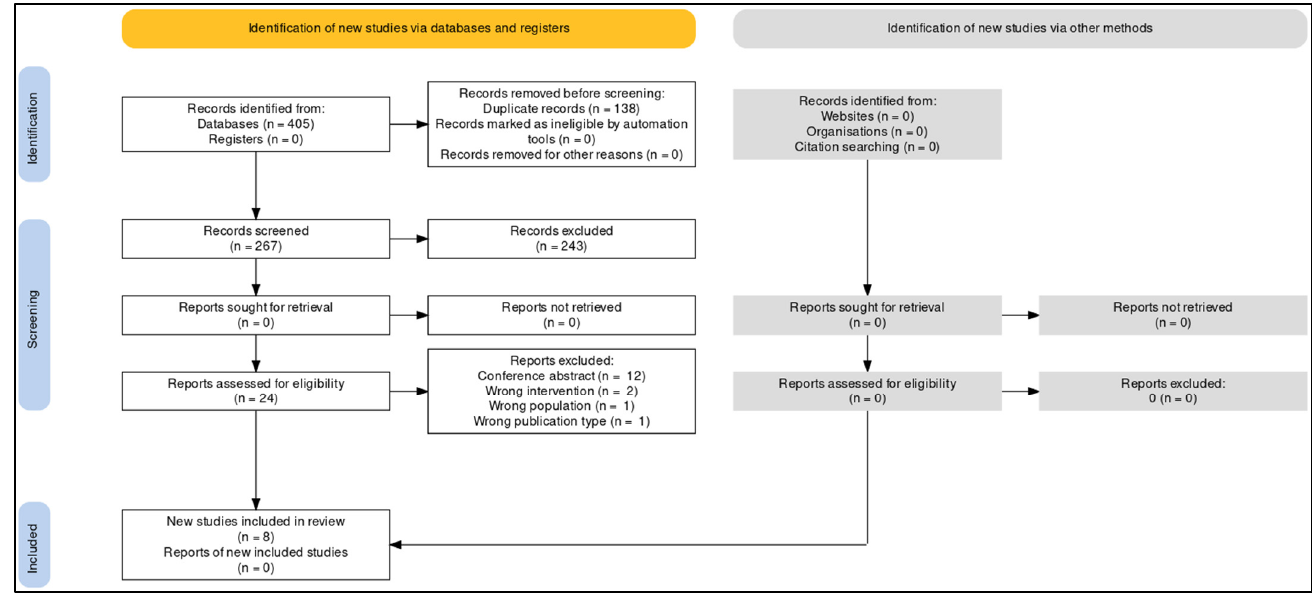
Figure 1. Study selection process.